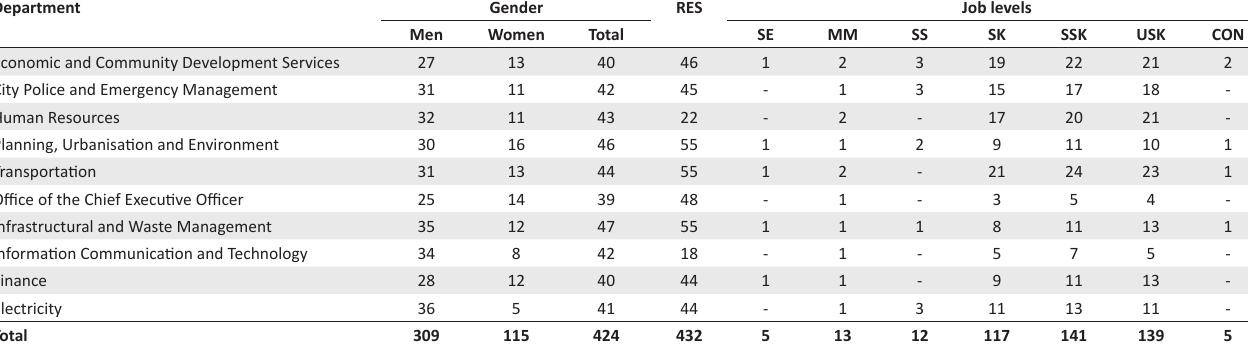
TABLE 3a: Gender distribution of respondents, number of respondents from each department and job levels.